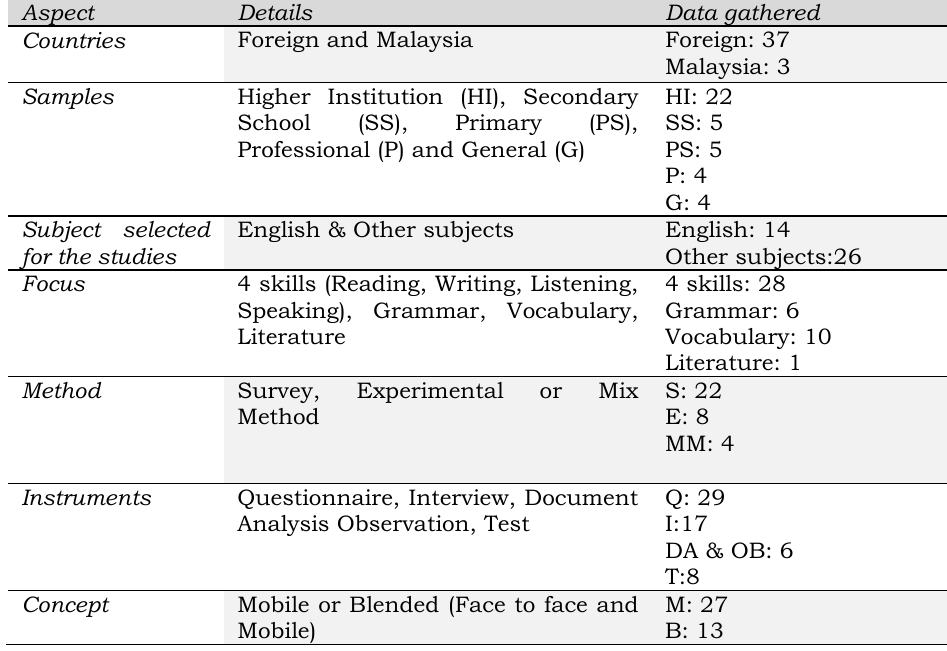
Table 3. Summary of the document analysis